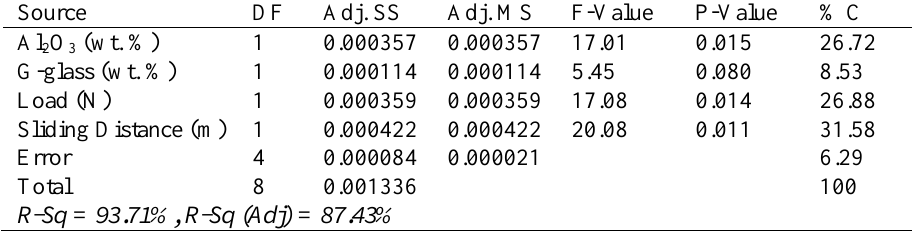
Table 4. Wear rate in Al7075 alloy hybrid composites was studied using ANOVA. Source G-glass (wt. %)